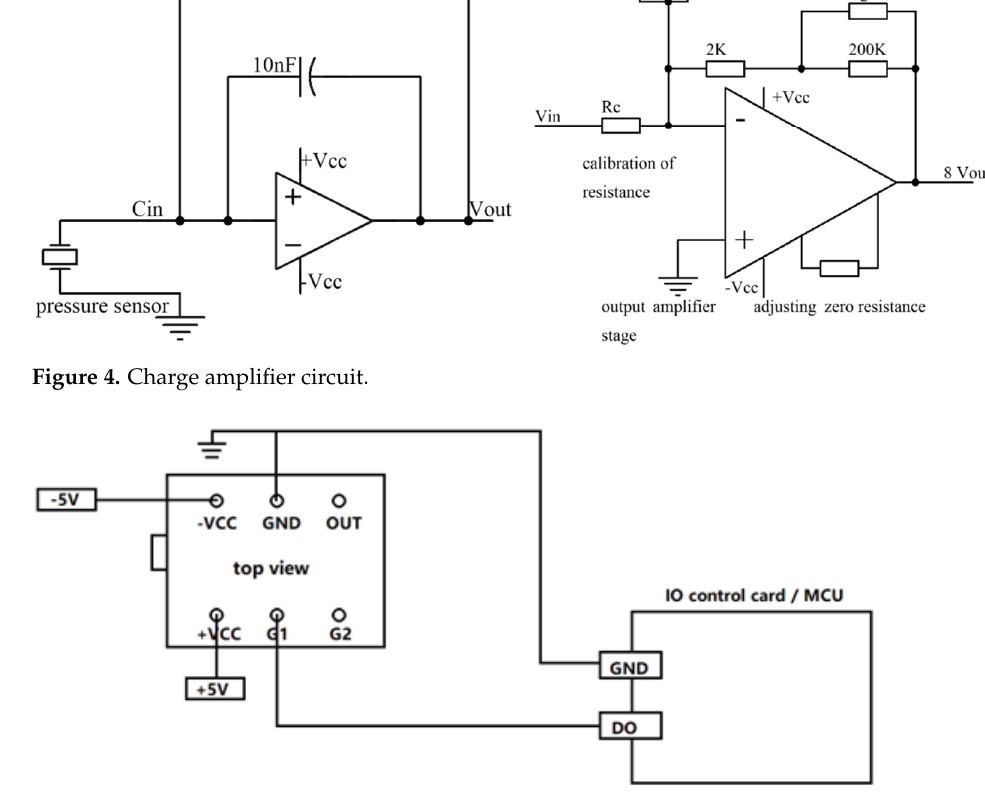
Figure 5. Connection diagram.